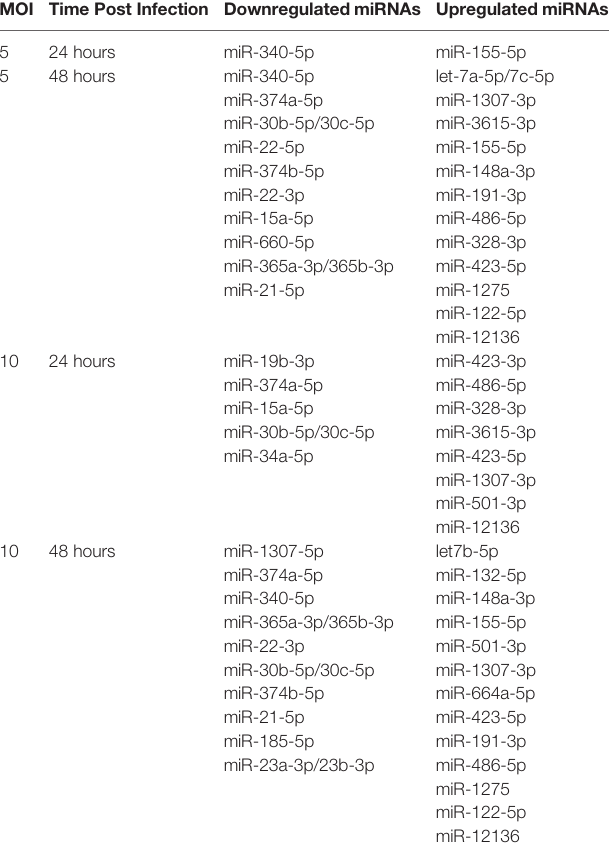
TABLE 1 | Signi fi cantly downregulated and upregulated miRNAs for each condition. MOI Time Post Infection Downregulated miRNAs Upregulated miRNAs